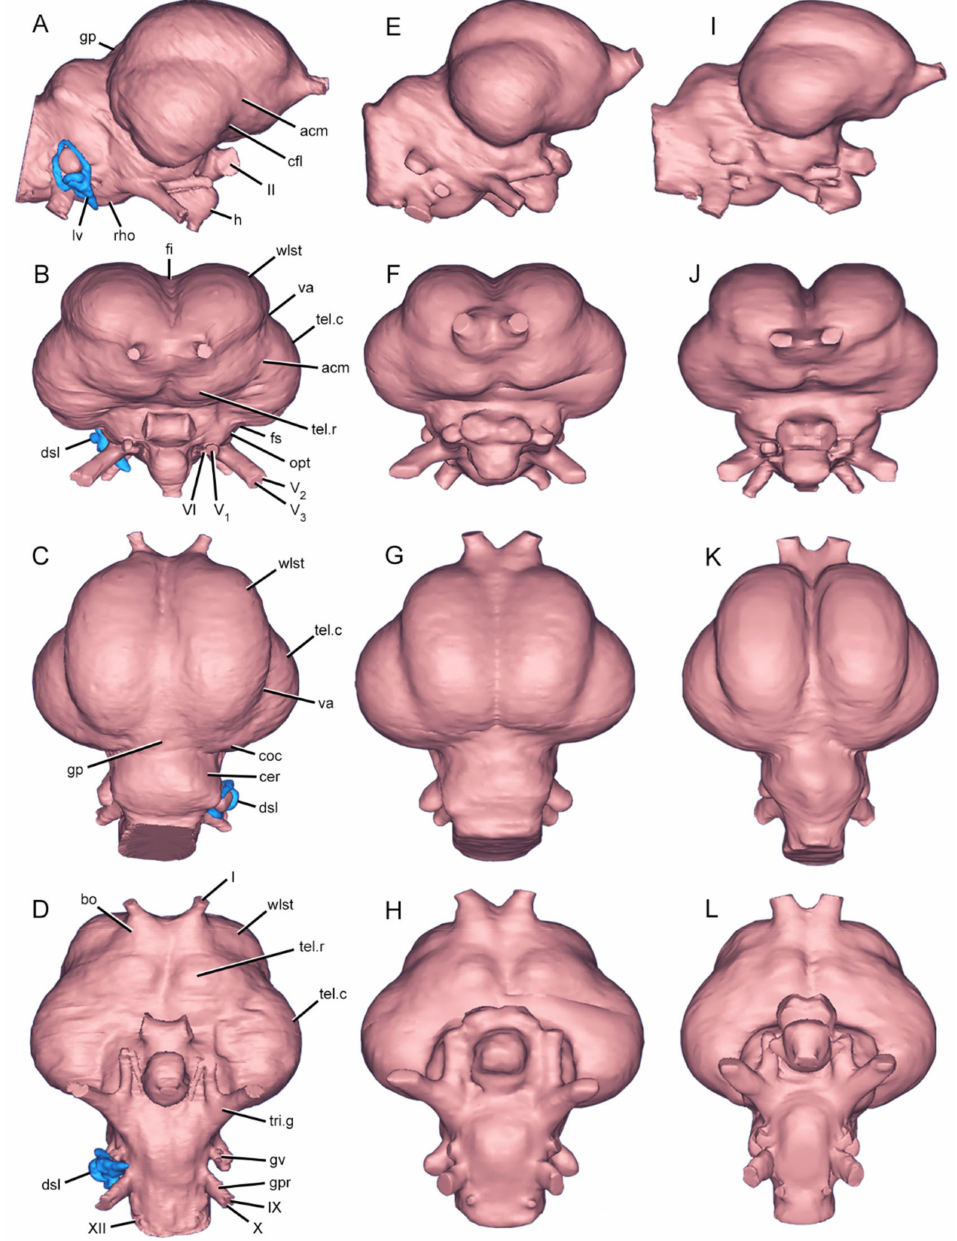
Figure 3. Dromornithid endocasts: ( A – D ), Dromornis planei (NTM P9464-106); ( E – H ), D. murrayi reconstruction (QM F57984 + QM F57974; see SI Figure S9); ( I – L) , Ilbandornis woodburnei (QVM:2000:GFV:20). Views. Right lateral ( A , E , I ); rostral ( B , F , J ); dorsal ( C , G , K ); ventral ( D , H , L ). Trigeminal nerves (V 1 , V 2 , V 3 ) are truncated where exiting the cranium. Abbreviations: acm, arteria cerebralis medialis; bo, olfactory bulb; cer, cerebellum; cfl, cerebrum fovea limbica; coc, cerebrum pars occipitalis; dsl, lateral semicircular duct; fi, fissura interhemispherica; fs, fissura subhemispherica; gp, glandula pinealis; gpr, proximal ganglion; gv vestibular ganglion; h, hypophysis; lv, vestibular organ (semicircular ducts + cochlea [blue]; see also Section 4.1.4); mm, millimetres; opt, optic lobe; rho, rhombencephalon; tel.c, caudal telencephalon; tel.r, rostral telencephalon; tri.g, trigeminal ganglion; va, vallecula telencephali; wlst, wulst; I, olfactory nerve; II, optic nerve; V 1 , ophthalmic nerve; V 2 , maxillary nerve; V 3 , mandibular nerve; VI, abducent nerve; IX, glossopharyngeal nerve; X; vagus nerve; XII, ramus of the hypoglossal nerve. Endocasts are not to